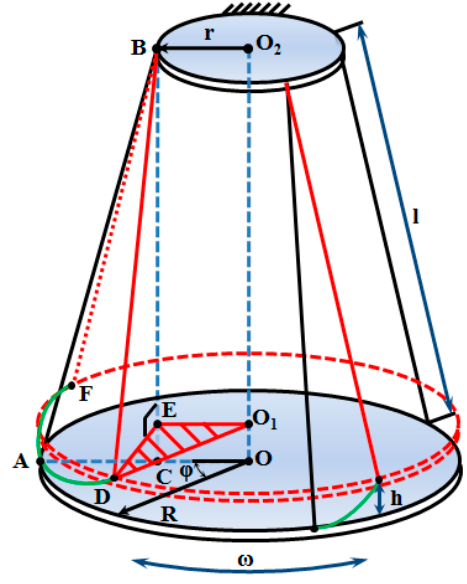
Figure 23. The main elements of the three-wire pendulum measuring chain.